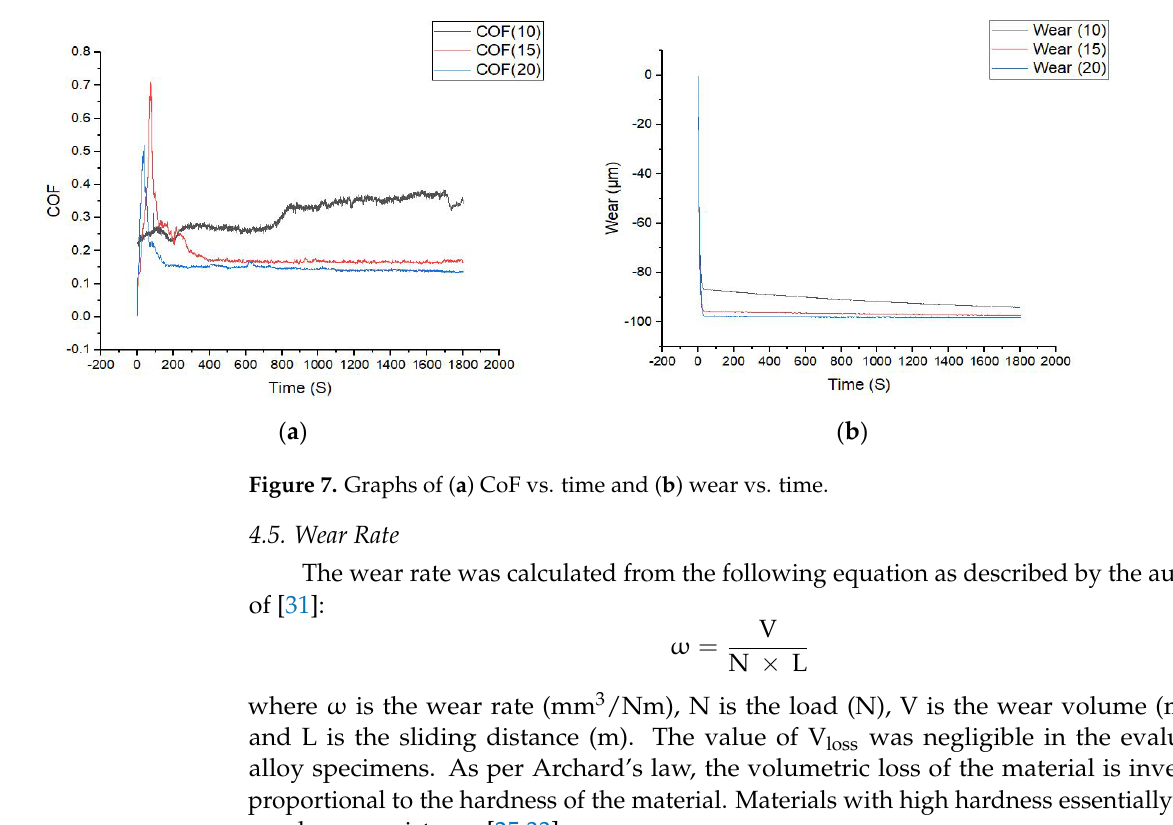
Figure 6. Wear tracks on ( a – c ) cladded specimens and ( d , e ) SEM images.